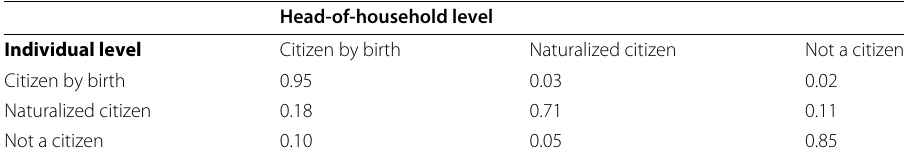
Table 4 Comparison table between individual and head-of-household variable citizenship status Head-of-household level Individual level